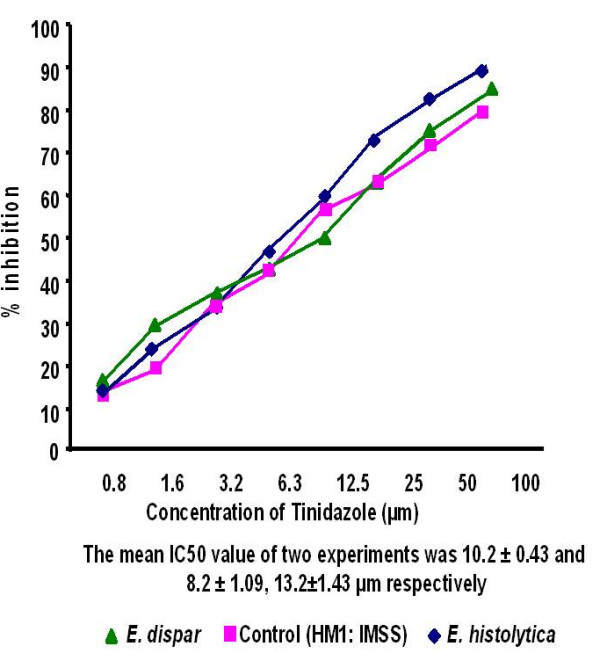
Percentage inhibition of E. histolytica (HM1: IMSS) and clinical isolates of E. histolytica and E. dispar by tinidazole